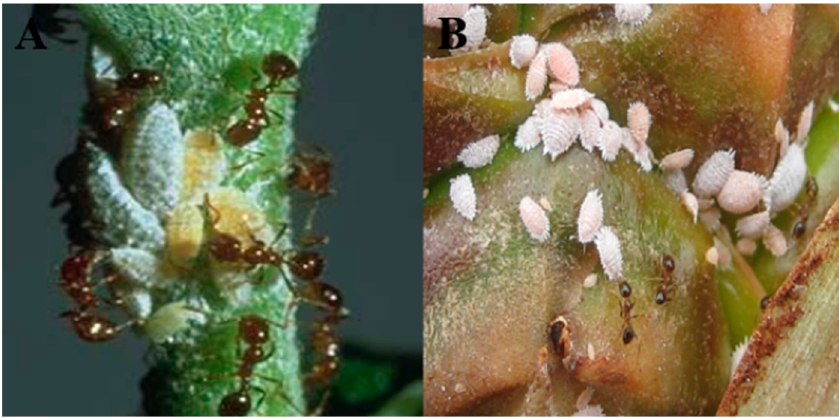
Figure 3. Mutualistic association of ants and mealybugs. ( A , B ) Big-headed ants tending mealybugs.